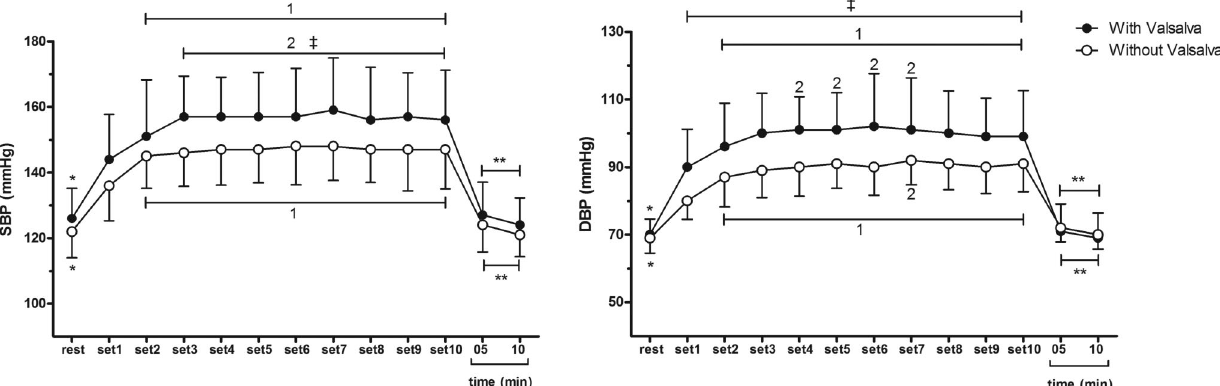
Figure 2 - Systolic blood pressure (SBP) and diastolic blood pressure (DBP) at rest, during stretching protocols performed with and without the Valsalva maneuver, and at 10 min post-exercise. Superscripted numbers represent significant differences vs . the indicated set. * : significant difference between the resting condition and all sets ( p o 0.05). ** : Significant difference between post-exercise assessments and all sets ( p o 0.05). = : Significant difference between sets in protocols performed with the VM vs. without the VM ( p o